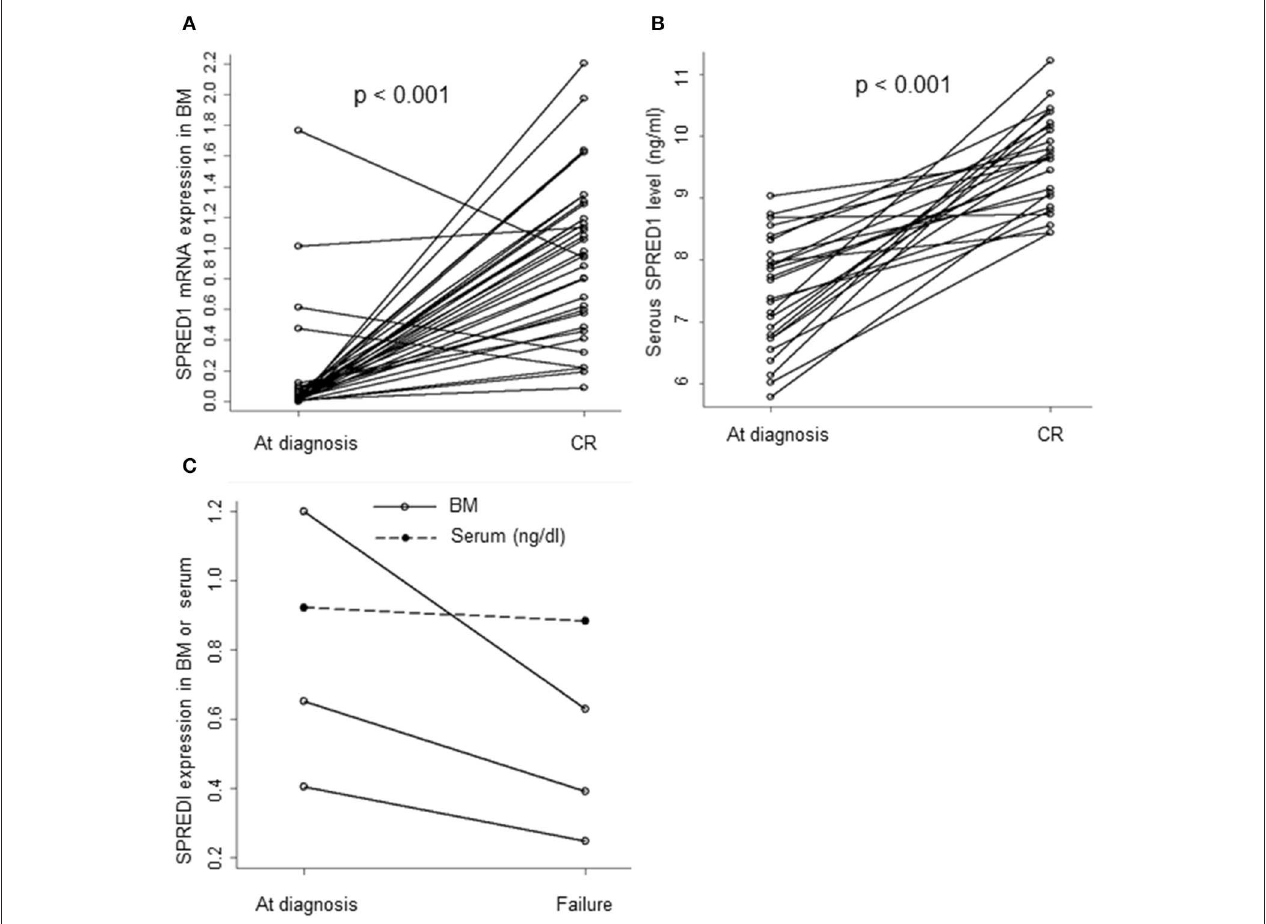
FIGURE 3 | SPRED1 in AML patients at diagnosis and post-treatment. SPRED1 in AML patients with CR at (A) mRNA (Paired Student’s t -test); (B) protein level (Paired Student’s t -test); (C) SPRED1 in AML patients induction failure at diagnosis and post-treatment.